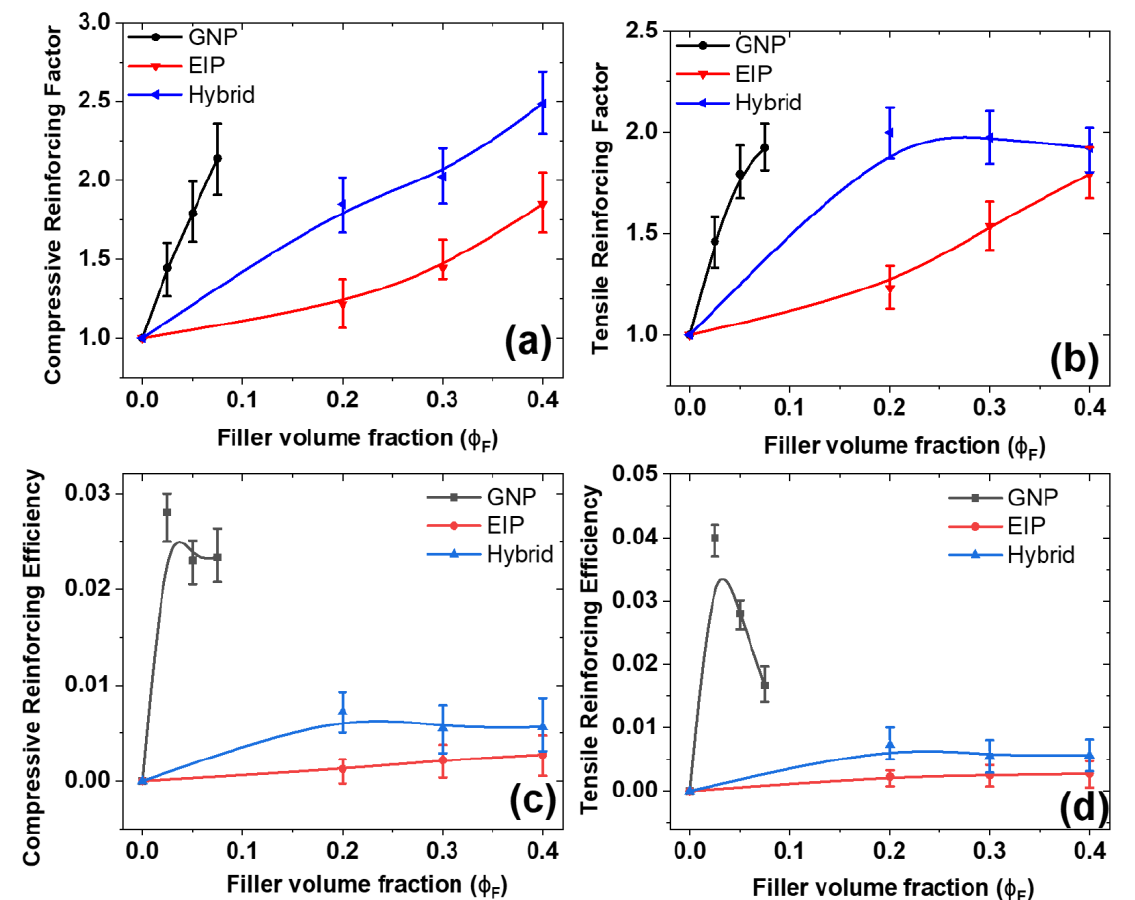
Figure 6. ( a ) Compressive-reinforcing factor of composites; ( b ) tensile-reinforcing factor of compo- sites; ( c ) compressive-reinforcing efficiency of composites; ( d ) tensile-reinforcing efficiency of com- posites.